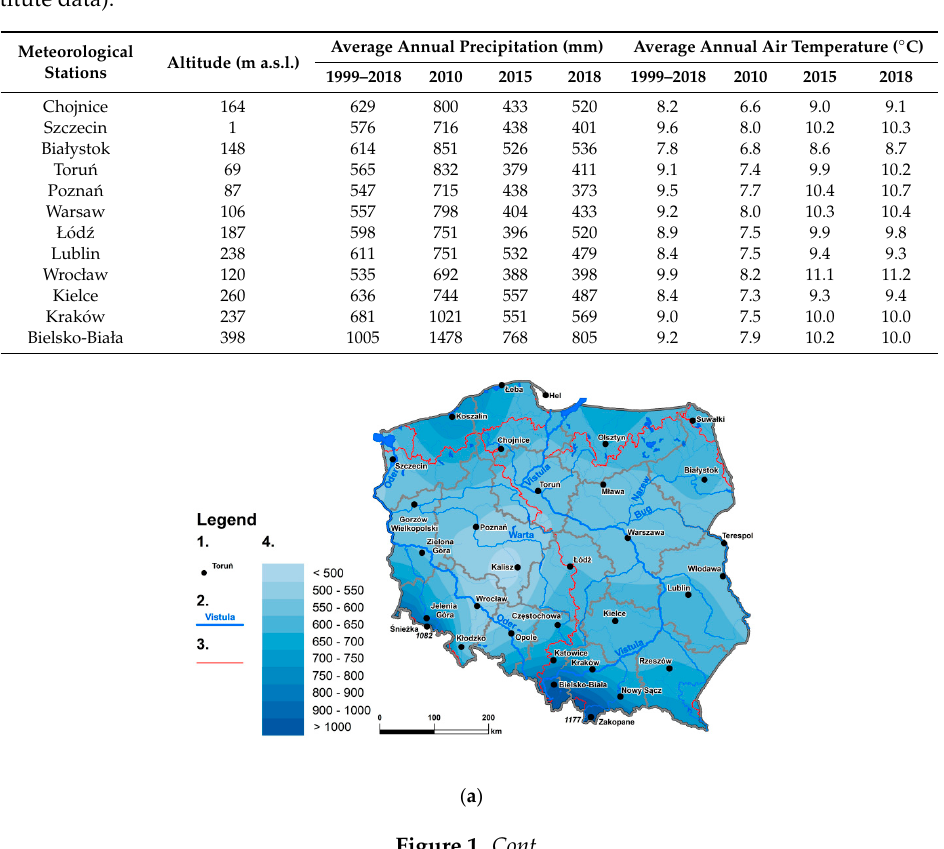
Table 1. Average annual precipitation and air temperature at selected meteorological stations in Poland in period 1999–2018 (based on Institute of Meteorology and Water Management—National Research Institute